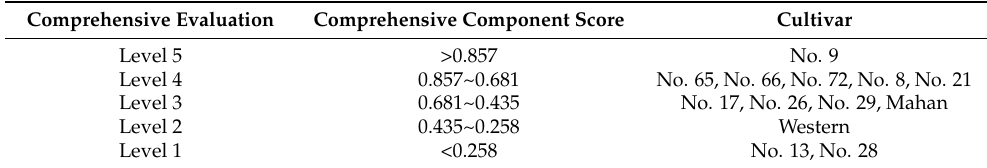
Table 7. The hierarchical differentiation of category 3 cultivars based on comprehensive components score (five